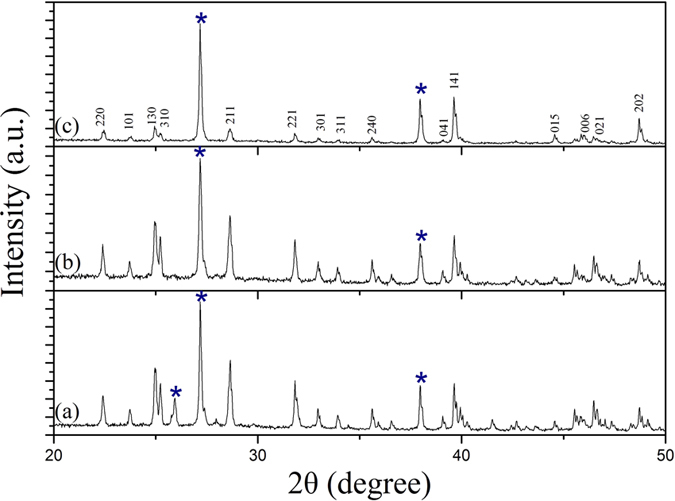
XRD patterns of Bi2S3: Eu3+ nanocrystals prepared at 180 °C for 12h with annealing at different temperatures for 2h: (a) 400 °C, (b) 600 °C, and (c) 800 °C.